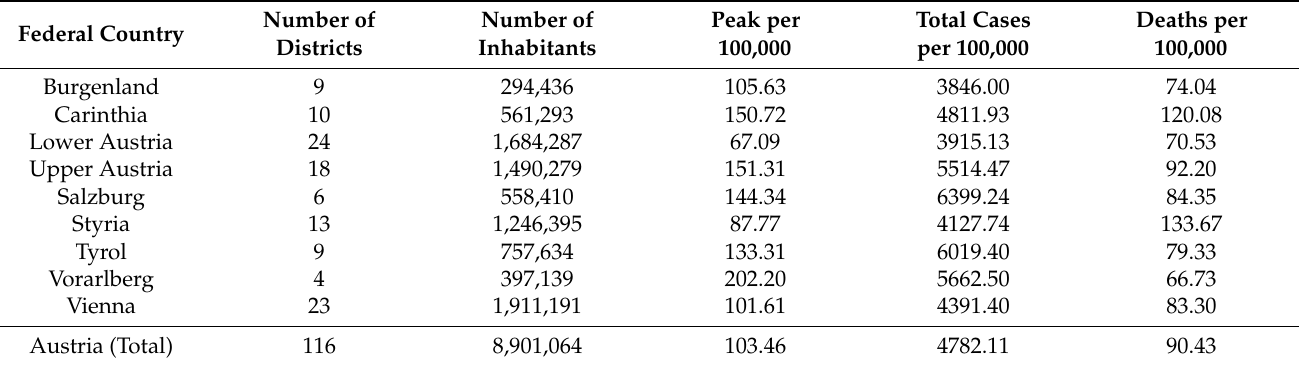
Table 1. Federal countries in